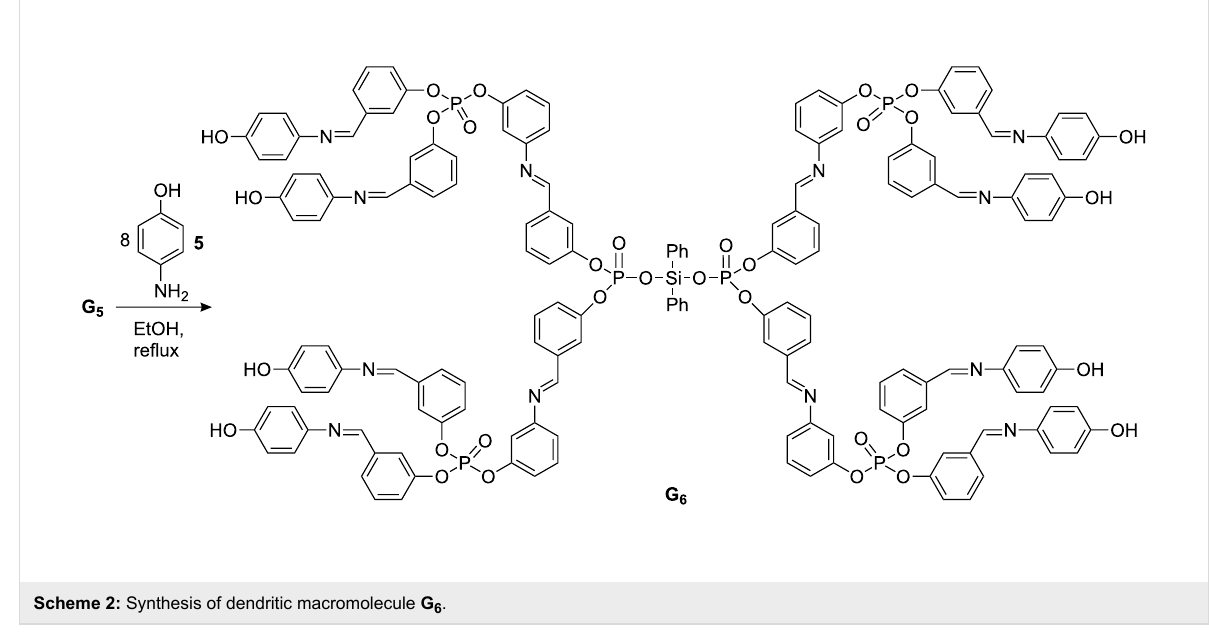
nance signals indicating two different types of phosphorus